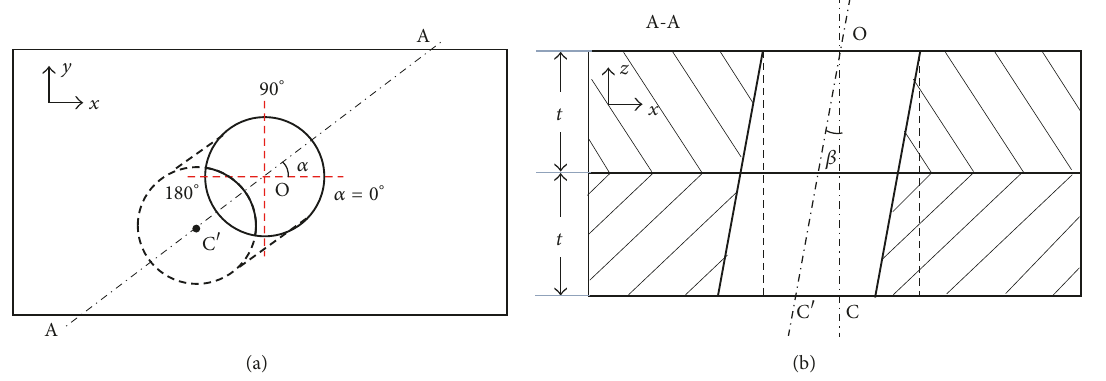
Figure 1: Characterization of perpendicularity error of hole from [9].